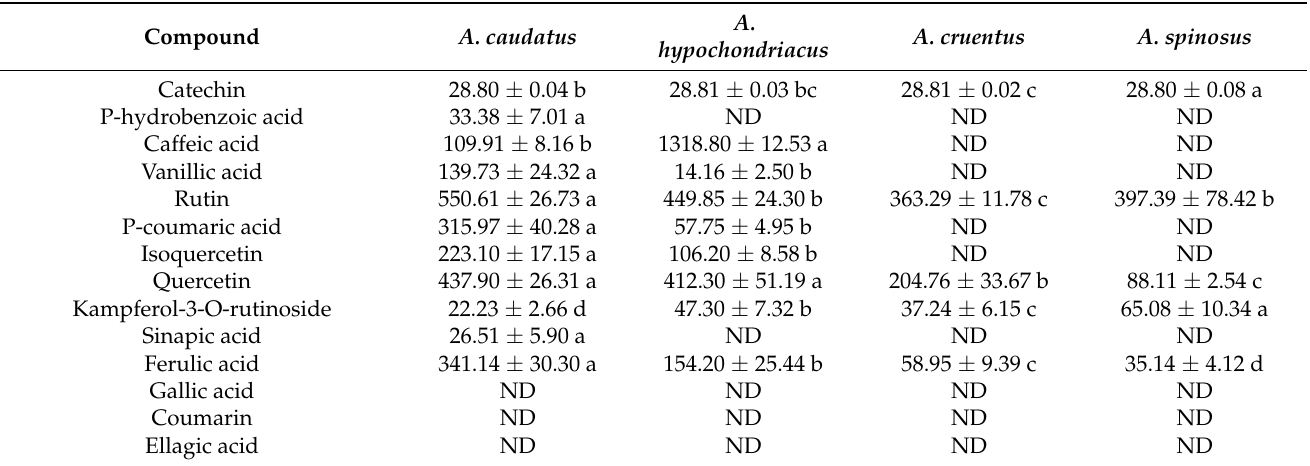
Table 1. Total phenolic and flavonoids compounds detected in leaves extract of Amaranthus species ( µ g/g DW). ND (not detected). Data are shown as mean ± standard deviation and different letters in the same row indicate significant differences ( p ≤